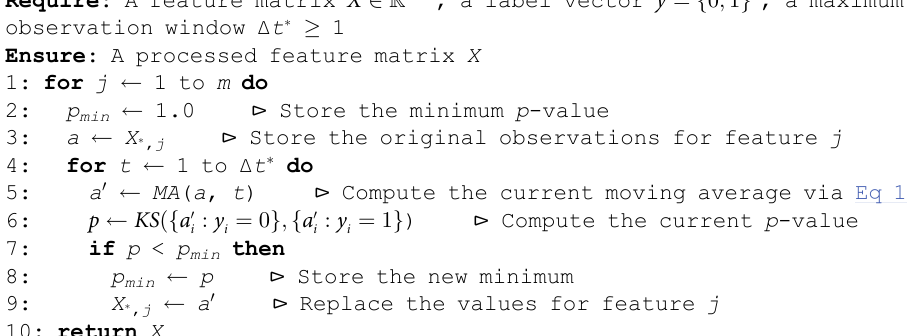
Algorithm 1. In summary, we first specify a maximum observation window Δ t � . Next, for each